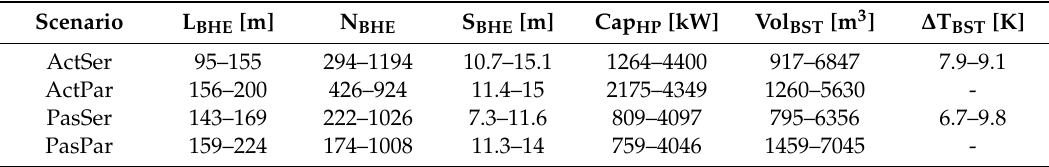
Table 6. Ranges of the optimized solutions on the Pareto